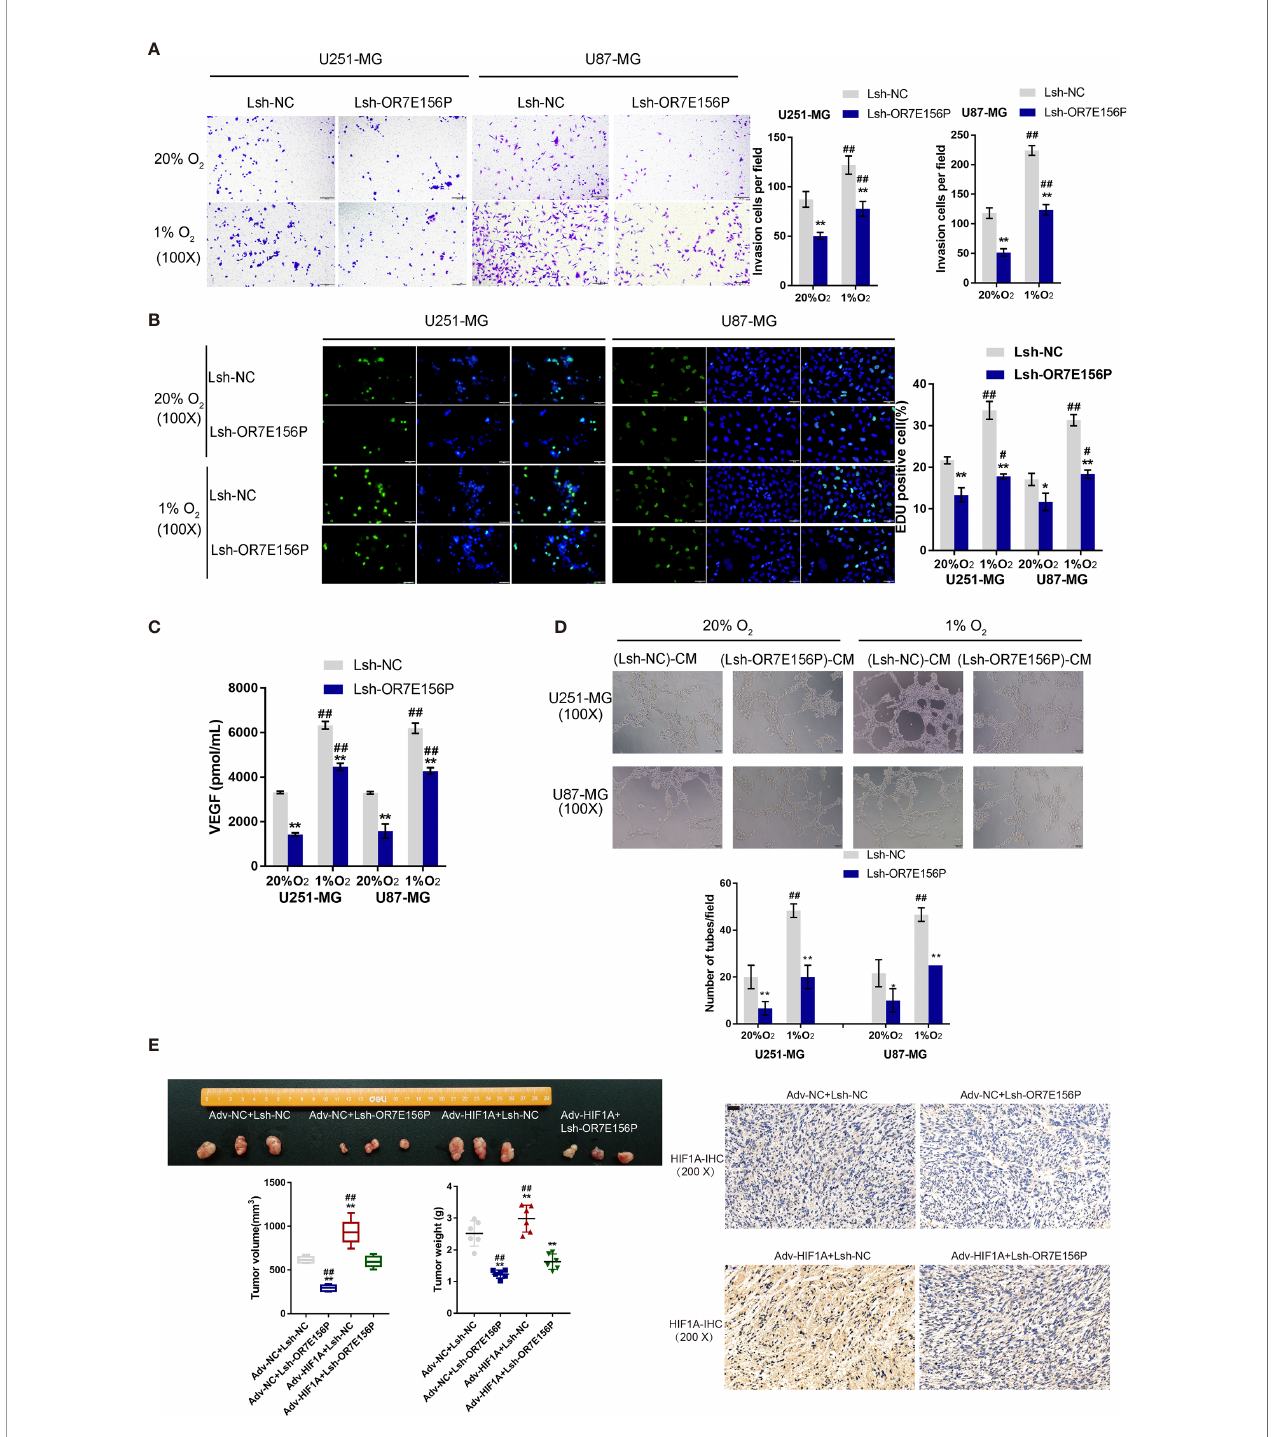
FIGURE 4 | Dynamic effects of HIF1A and OR7E156P on glioma in vitro and in vivo U251-MG and U87-MG cells were transduced with Lsh-OR7E156P or Lsh-NC, exposed to 1% O 2 or 20% O 2 , and examined for cell invasion by Transwell (A) and DNA synthesis capacity by EdU (B) . (C) Conditioned medium was obtained from Lsh-OR7E156P- or Lsh-NC-infected U251-MG and U87-MG cells and used for human umbilical vein endothelial cell (HUVEC) culturing; the content of VEGF in culture medium was determined by ELISA. (D) The tube formation capacity of HUVEC in different conditional culture medium was determined. (E) Tumor volumes and weights from mice bearing tumors derived from glioma cells infected or co-infected with Adv-HIF1A (Adv-NC as control) and/or Lsh-OR7E156P (Lsh-NC as control) were measured and calculated. HIF-1 a protein content and distribution in tumor tissues was examined by IHC staining. * P < 0.05, ** P < 0.01, # p < 0.05, ## P <